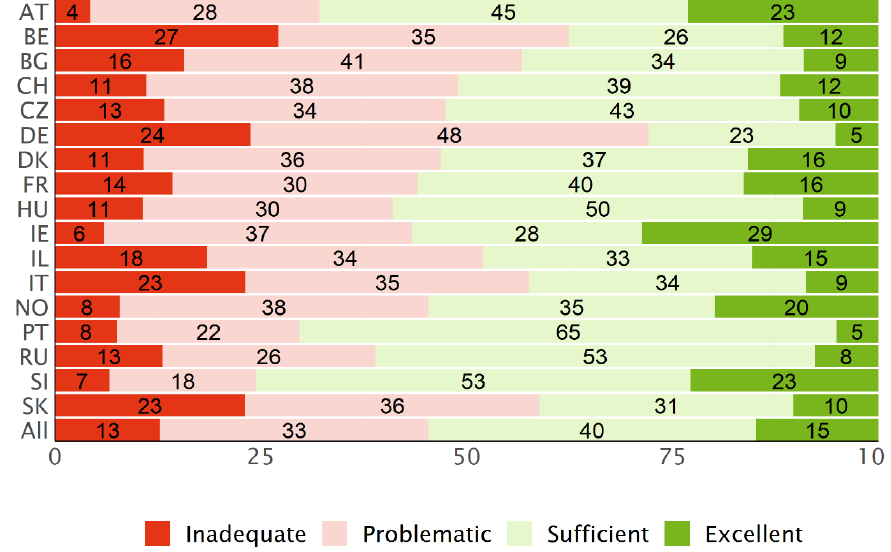
Figure 4. Distribution of the HLS 19 -Q12 levels for general HL, based on type D scores, for each country and the mean for all countries.